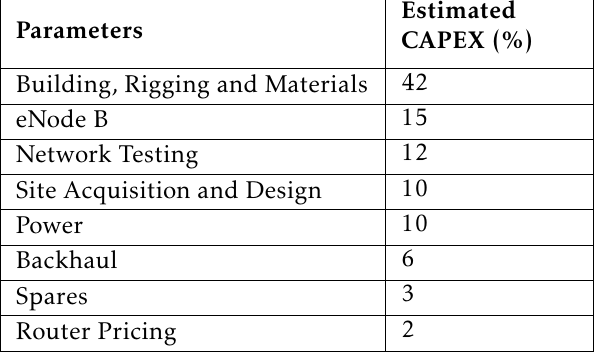
Table 1. CAPEX analysis for mobile network [44].